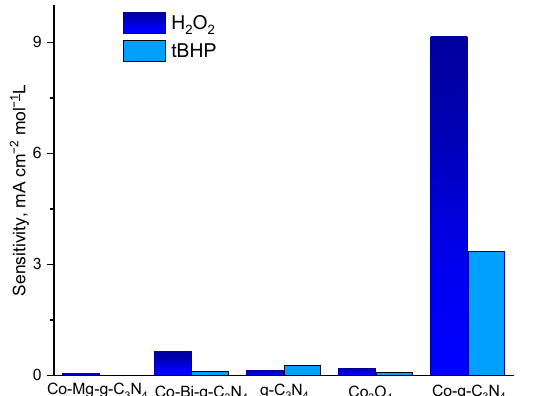
Figure 1. The sensitivity of a catalytic electrode upon electrochemical reduction of H 2 O 2 (dark blue series) and t-butyl hydroperoxide (blue series) in neutral aqueous medium; operational potential − 0.2 V ( − 0.415 V vs. RHE); reference electrode Ag|AgCl, sat. KCl; room temperature 21 ± 1 °C. Catalyst load for all the electrodes: 0.01 mg.